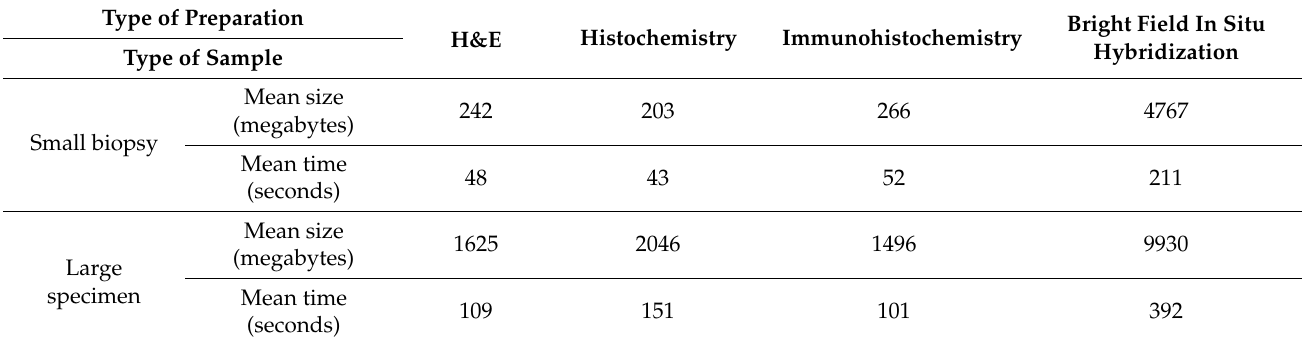
Table 2. Average sizes of slides and respective times for scanning concerning the type of